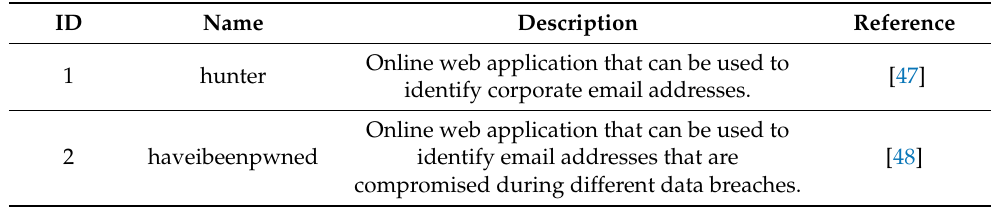
Table 8. Tools used for OSINT on email